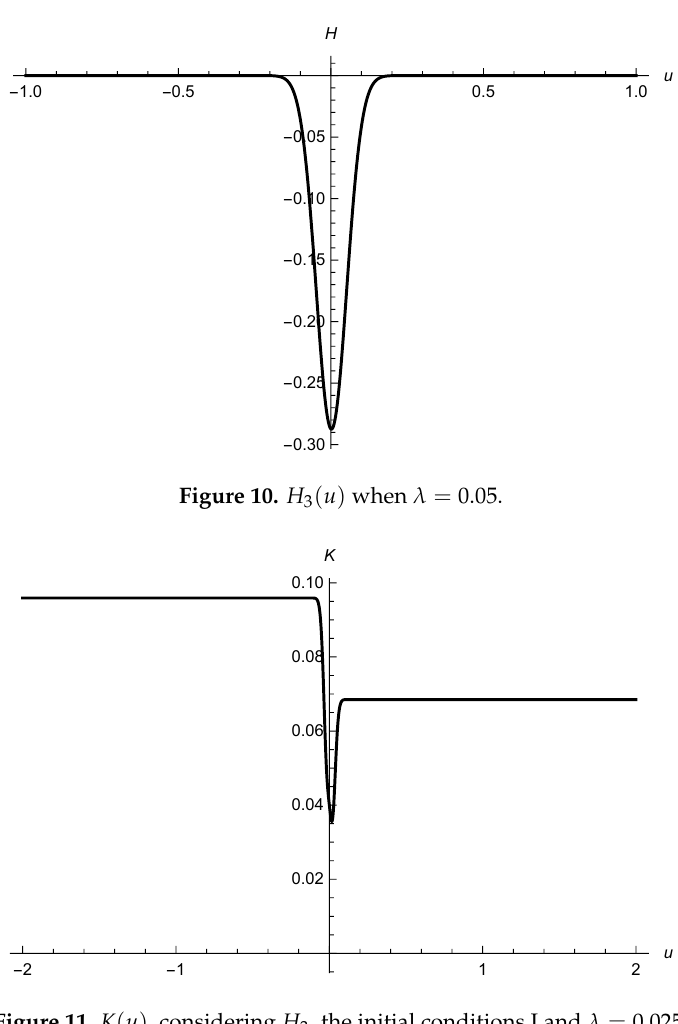
Figure 11. K ( u ) , considering H 3 , the initial conditions I and λ =